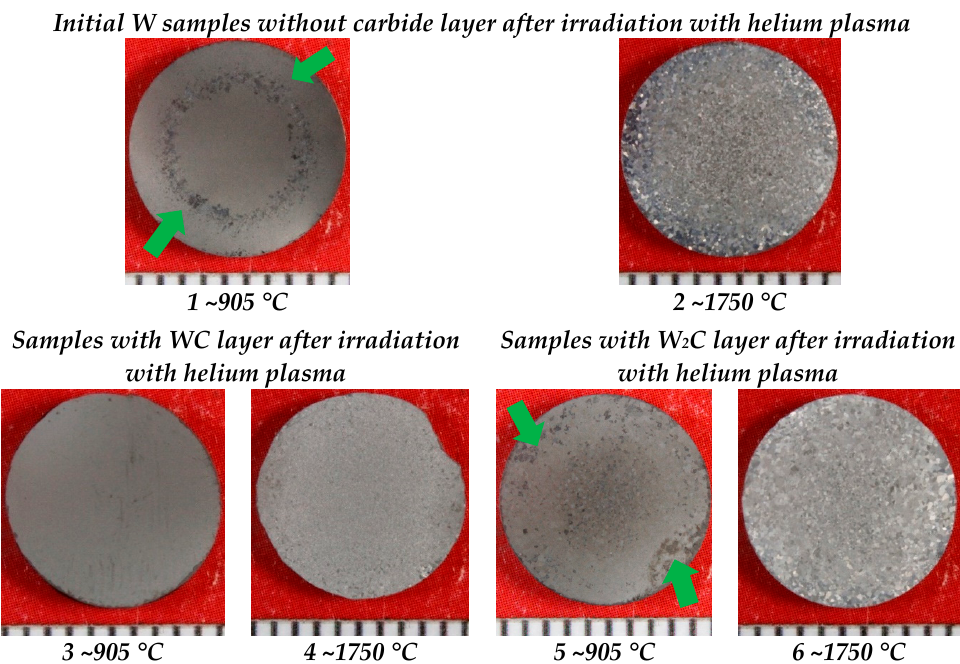
Figure 4. Surface of the initial and with carbide-layer tungsten samples after irradiation with helium plasma at temperatures of ~905°C and ~1750°C.